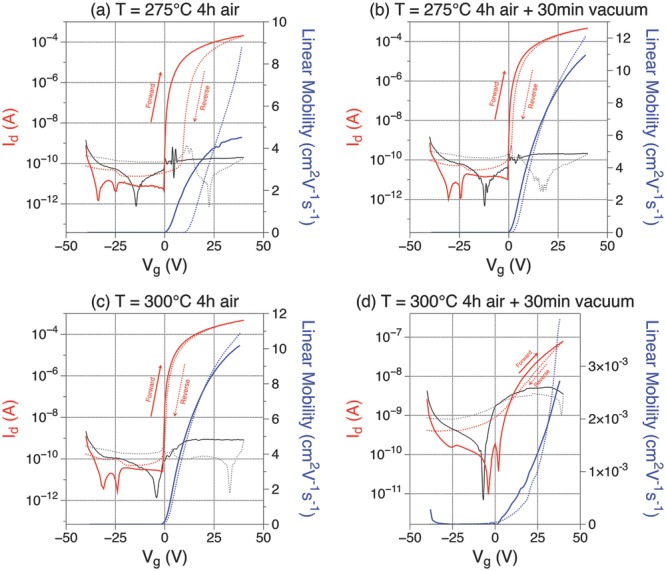
Red: drain current. Black: gate leakage current. Blue: linear mobility.
Solid lines represent forward scan. Dotted lines represent reverse scan.
Transfer curves for samples annealed at different temperatures in air with
and without an additional vacuum annealing step
(In2O3:ZnO = 6:4, W/L = 3000/300
μm, Vd = 5 V): Left: 4 h air
anneal only; Right: 30 min additional vacuum annealing; Top: 275 °C;
Bottom: 300 °C.